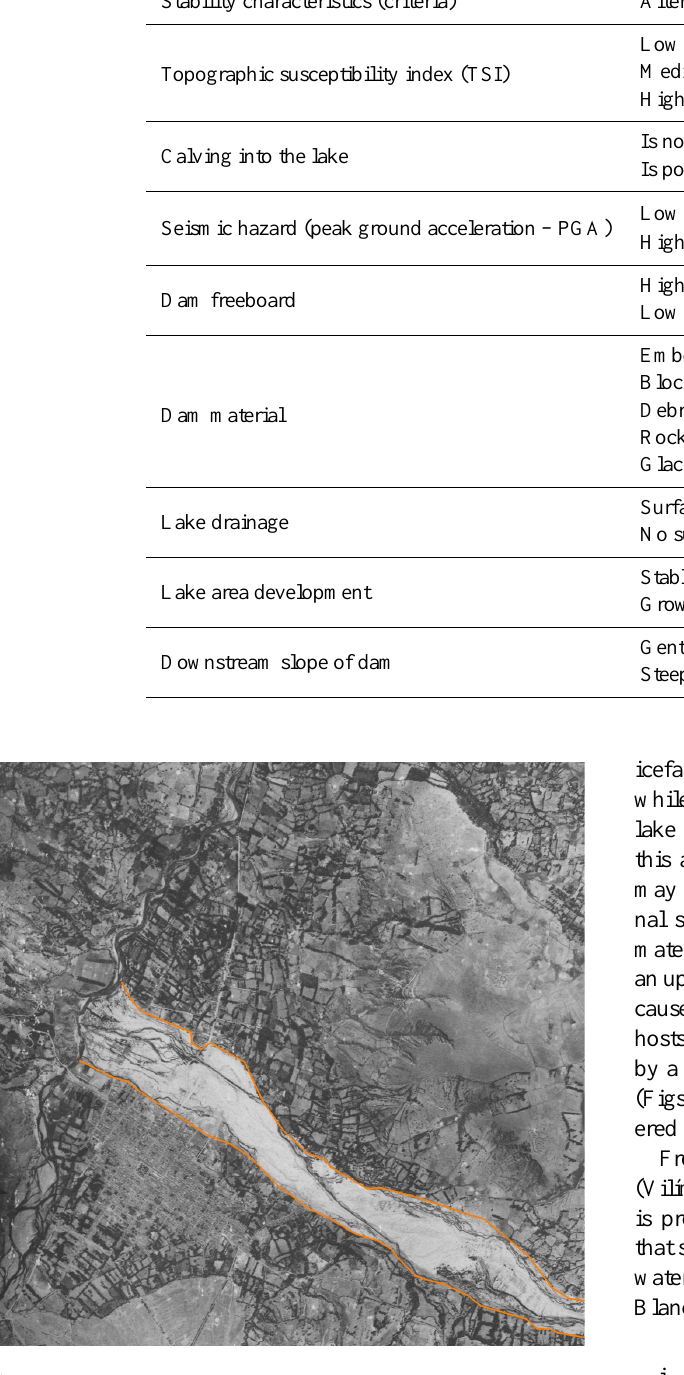
Fig. 4. An aerial photograph of the destroyed city of Huaraz follow- ing the aluvi ´ on from Lake Palcacocha. The area affected is defined by the orange line; the photograph was taken in 1948, seven years after the flood (Source: INRENA/ANA, Project